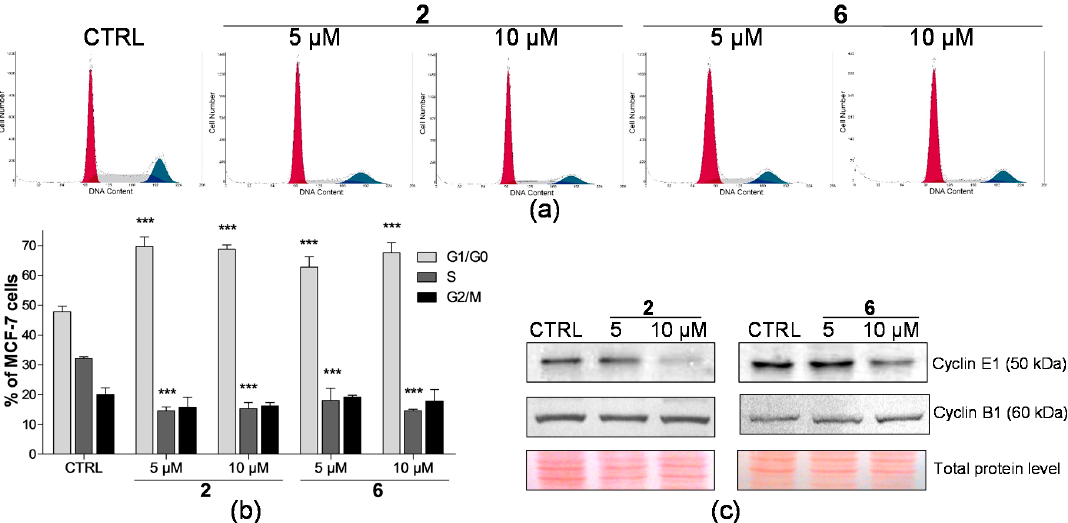
Figure 3. Compounds 2 and 6 induce accumulation of MCF-7 cells in the G1 phase. ( a ) Representative histograms of flow cytometric analysis of the DNA content in MCF-7 cells after the incubation with indicated concentrations of compounds 2 and 6 for 24 h; ( b ) The distribution of MCF-7 cells in phases of the cell cycle upon the treatment with compounds 2 and 6 at 24 h. The results are expressed as the means ± SD of three independent experiments. *** p < 0.001, statistically significant difference in comparison with control sample; ( c ) Expression of cell cycle regulators cyclin E1 and B1 in MCF-7 cells treated by compounds 2 and 6 for 24 h, as determined by Western blot analysis. Protein levels of the samples were normalized according to the total protein stains. CTRL, control cells treated by the drug-free medium.